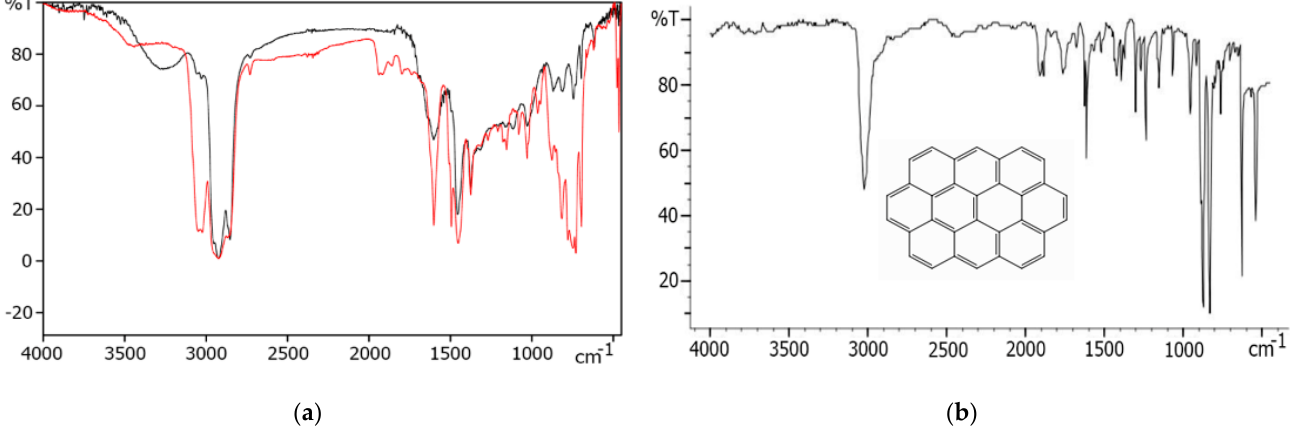
Figure 1. IR spectra of petroleum asphaltenes Petroleum ‐ A (black) and technogenic asphaltenes ET ‐ A (red) ( a ), ovalene ( b ). (red) ( a ), ovalene ( b